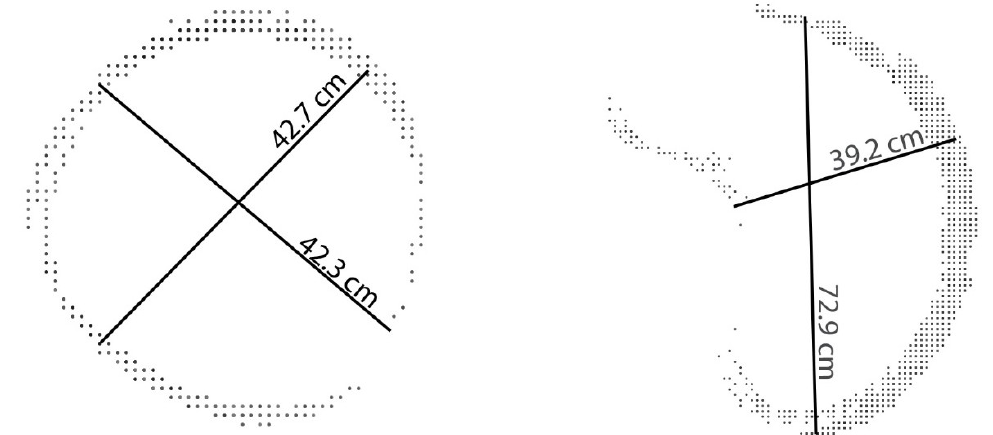
Figure 5. Two examples of measured DBH from TLS-point clouds from two different directions.